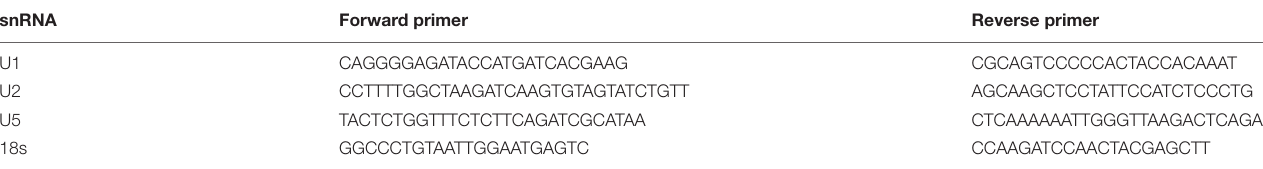
TABLE 1 | Sequence information of the primers for qRT-PCR.